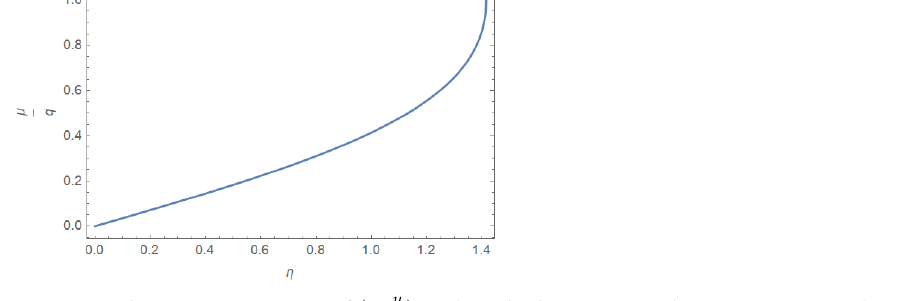
Figure 5. The parameter space of ( η , µ frequencies could